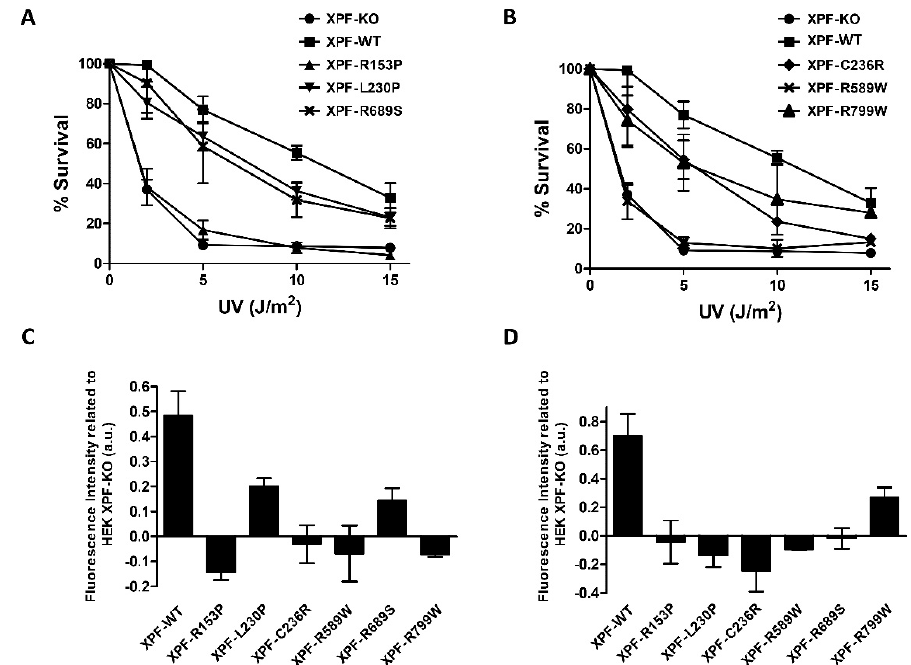
Figure 2. ( A , B ) Percentage of surviving cells after increasing doses of ultraviolet (UV) irradiation. Mean of at least two independent experiments of two replicates and the standard deviation is represented in the two graphs. ( C ) Unscheduled DNA synthesis (UDS) assay. Fluorescence intensity is represented relative to fluorescence intensity of Human Embryonic Kidney (HEK) XPF-KO. The graph represents the mean of at least three independent experiments with SD. ( D ) RRS assay. Fluorescence intensity is represented relative to fluorescence intensity of HEK XPF-KO. The graph represents the mean of at least three independent experiments with SD.